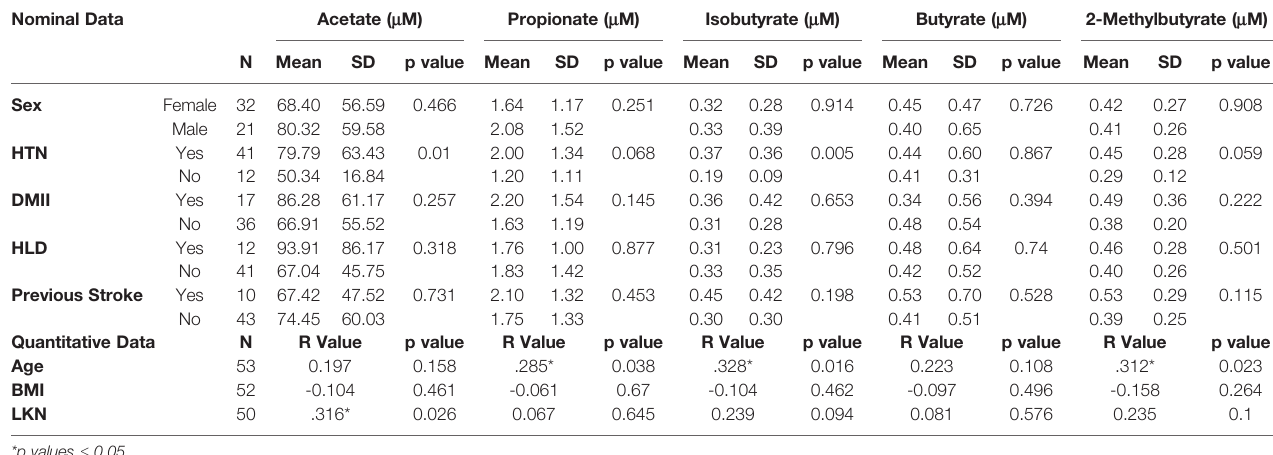
TABLE 2 | Differences in plasma SCFA concentrations between nominal patient demographics and comorbidities (top) and Pearson Correlations between quantitative patient demographics and SCFA concentrations (bottom). Nominal